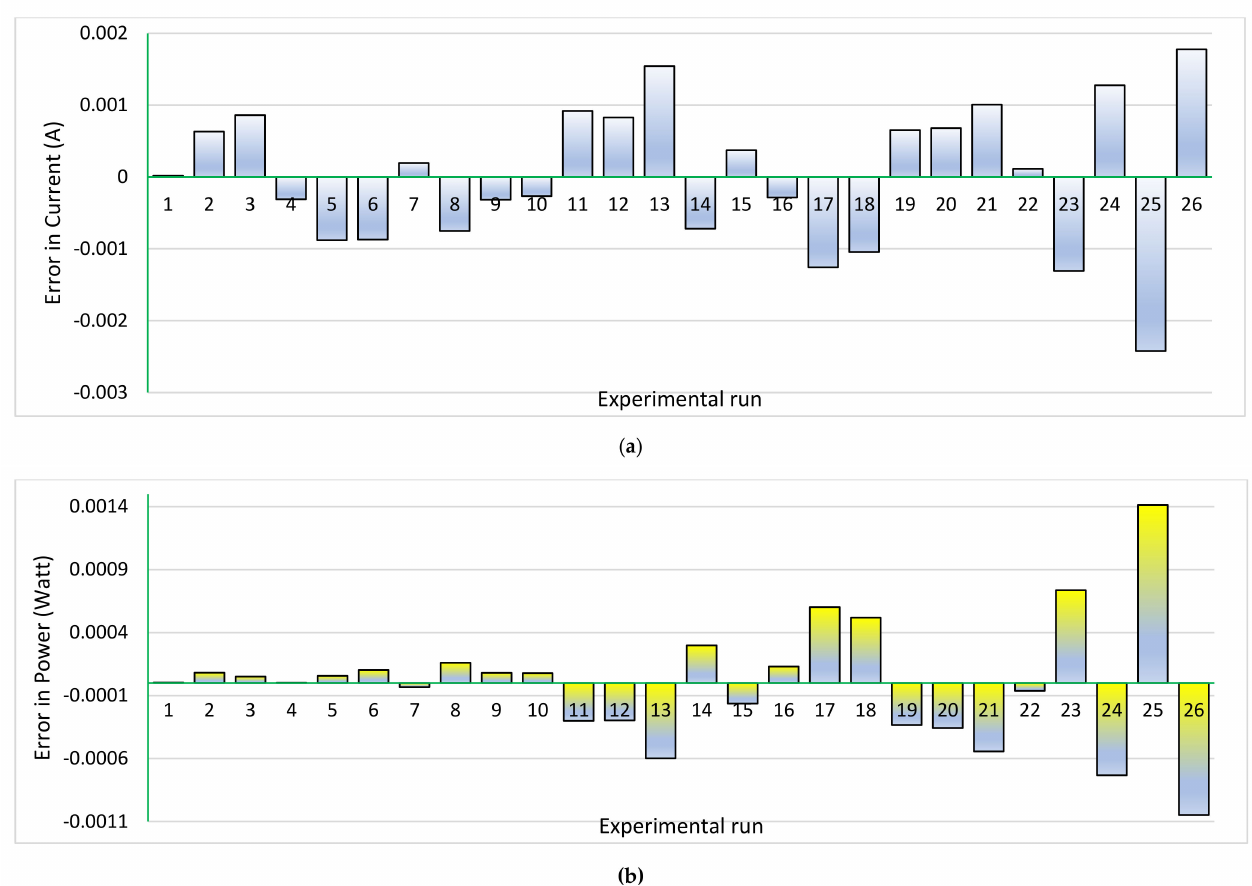
Figure 15. Error values for R.T.C. France TDM based on TFWO: ( a ) Current error values and ( b ) power error values.